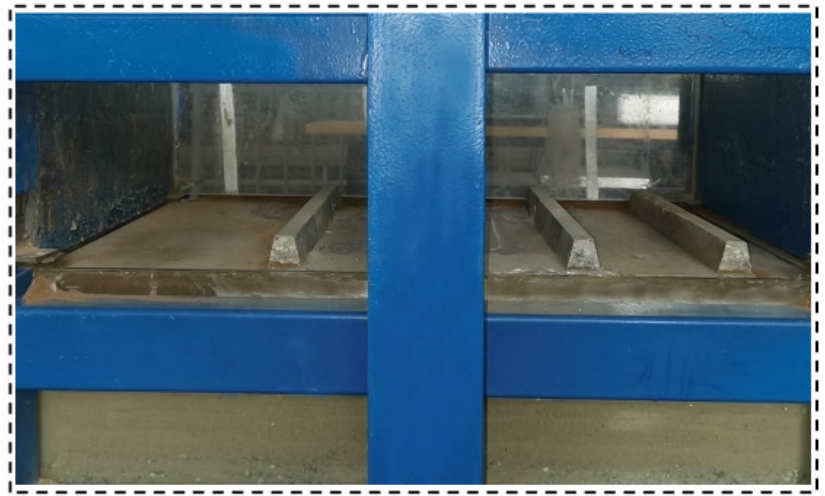
Figure 5. Arrangement of the 8 b screw shear